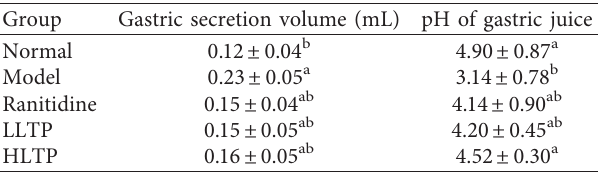
Table 3: Gastric secretion volume and pH of gastric juice in mice with gastric